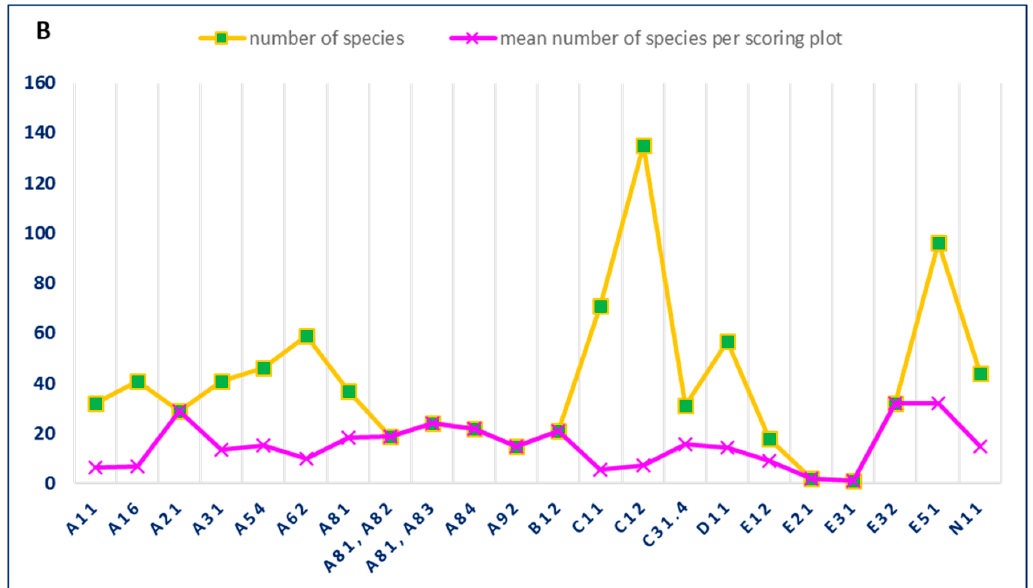
Figure 1. Plant diversity in the regions of study. ( A )—Pazardzhik-Plovdiv Region; ( B )—Western Stara Planina region .